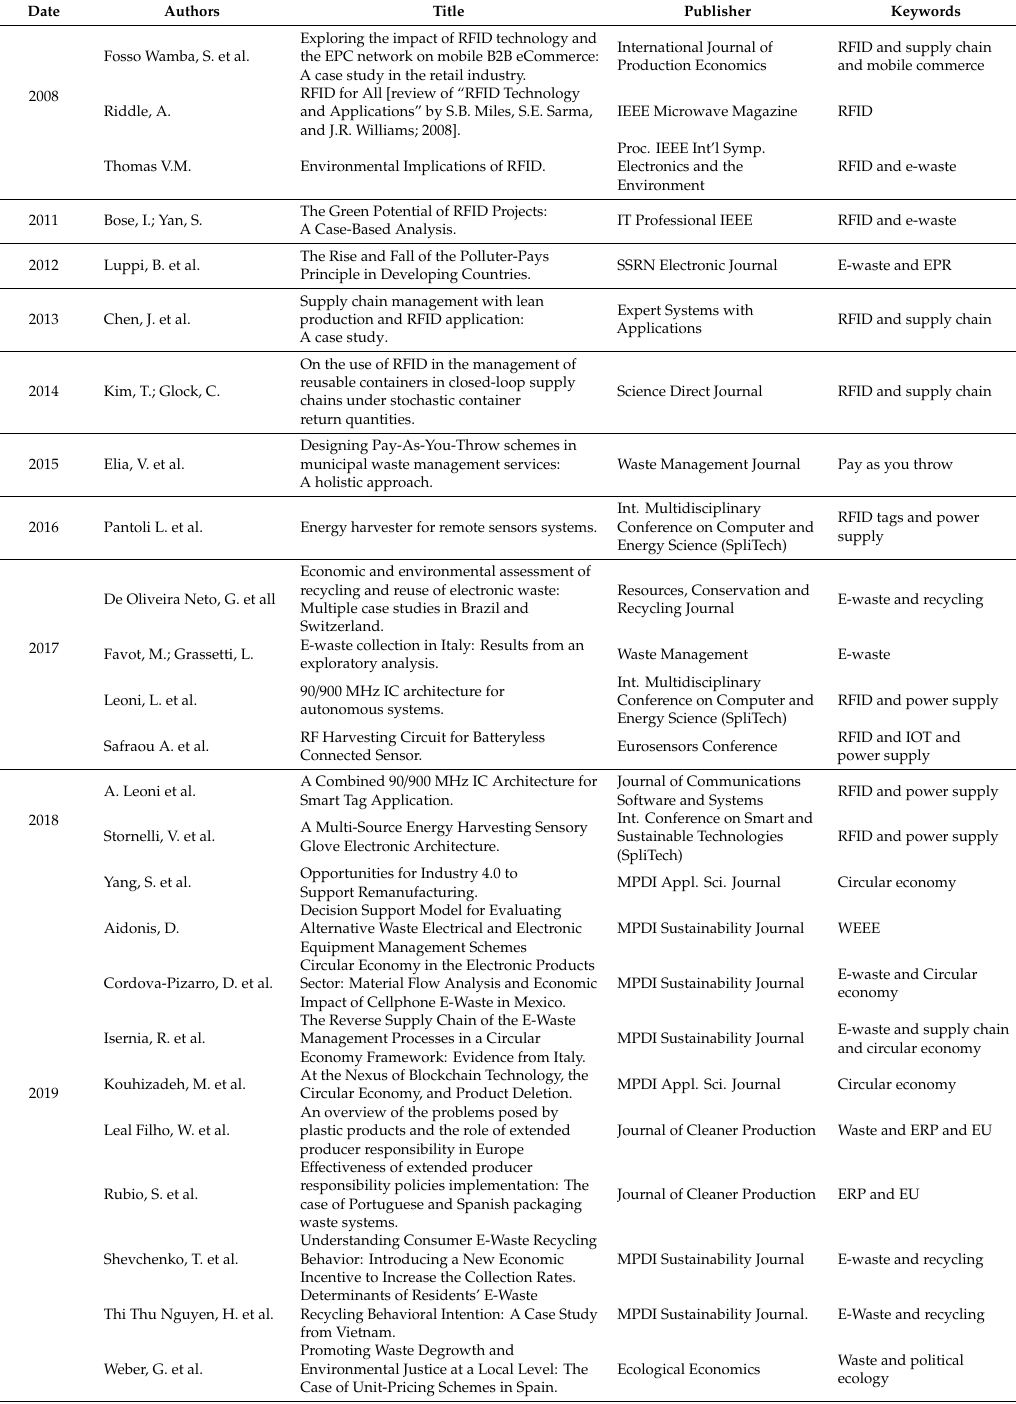
The web was used to search for the complete texts of the laws and to identify the companies that use RFID tags. The same web highlighted the lack of companies that are concerned with the reuse and recycling of RFID tags. In fact, by typing the keywords “RFID” and “e-waste tags”, the obtained results are all related to companies that use tags for the traceability of waste. Only SMART RES s.p.a. is concerned with producing biodegradable RFID tags. In Table 2, these websites are reported, sorted according to the keywords and the date of